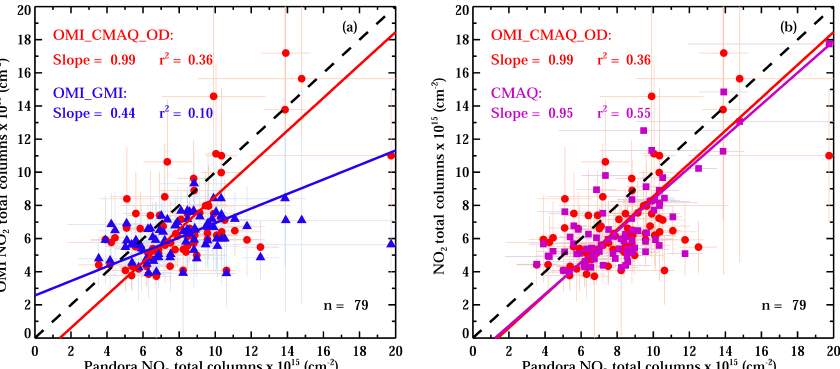
Figure 7. (a) Total column NO 2 OMI_GMI and OMI_CMAQ_OD vs. co-located spatially and temporally Pandora NO 2 total column measurements within ± 1h of a valid satellite overpass during July 2011. (b) Same but now showing CMAQ instead of OMI_GMI; the stratospheric vertical column from NASA Level 2 product has been added to CMAQ to ensure a fair comparison. Error bars on both plots represent ± 1 SD away from the mean.